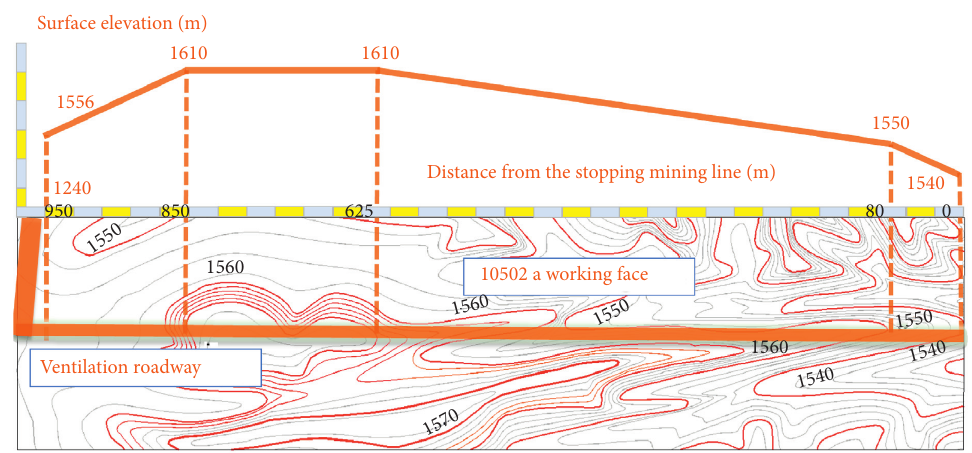
Figure 7: Surface elevation changing characteristics above the ventilation roadway in the 10502 working face.